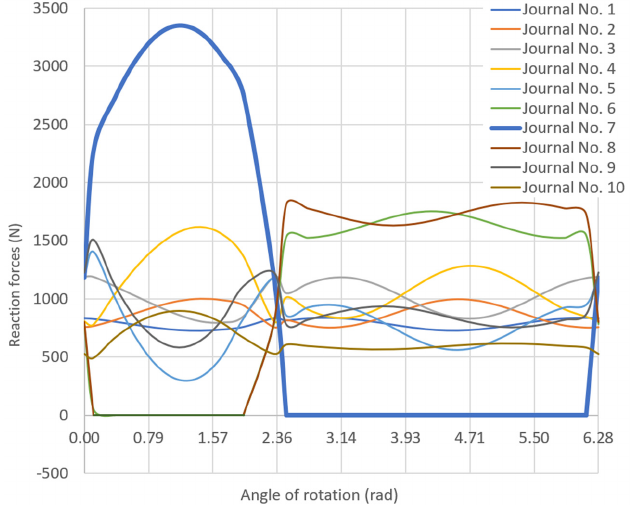
Figure 20. Variation of the support reaction forces for the case where journal No. 7 shows the eccentricity e = 32 µm while the support is lifted in relation to the others by x = 12.8 µm.